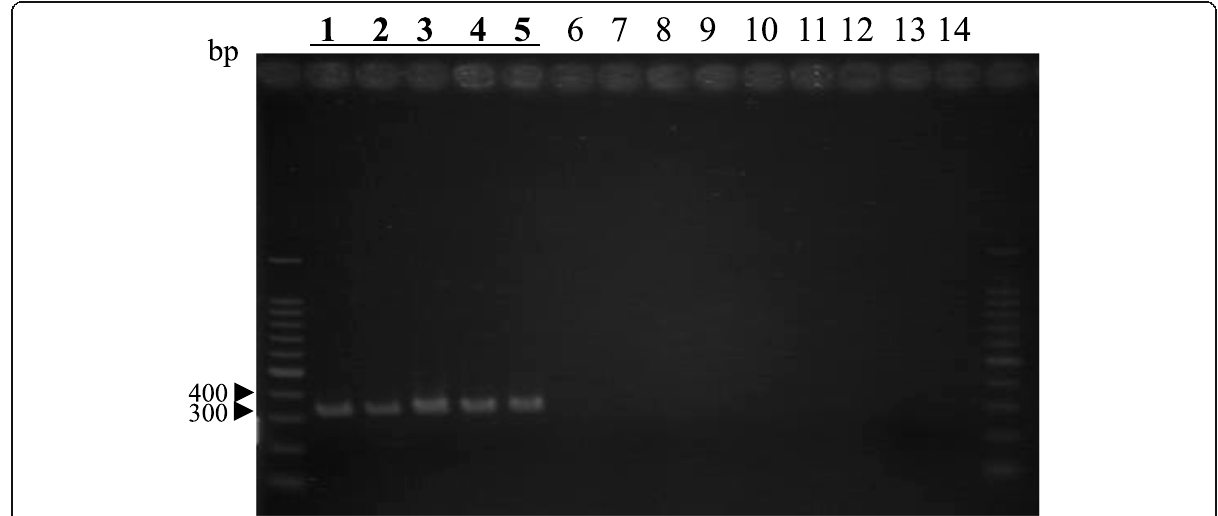
Fig. 2 Amplified products obtained by the primer pair Lhs-F1/R1. Lanes 1 – 4: lily isolates of Fusarium oxysporum pathogenic to lilies; lane 5: F. oxysporum f. sp. lilii ; lanes 6 – 13: tester isolates of F. oxysporum ; lane 14: negative control. Marker used was 100 ladder